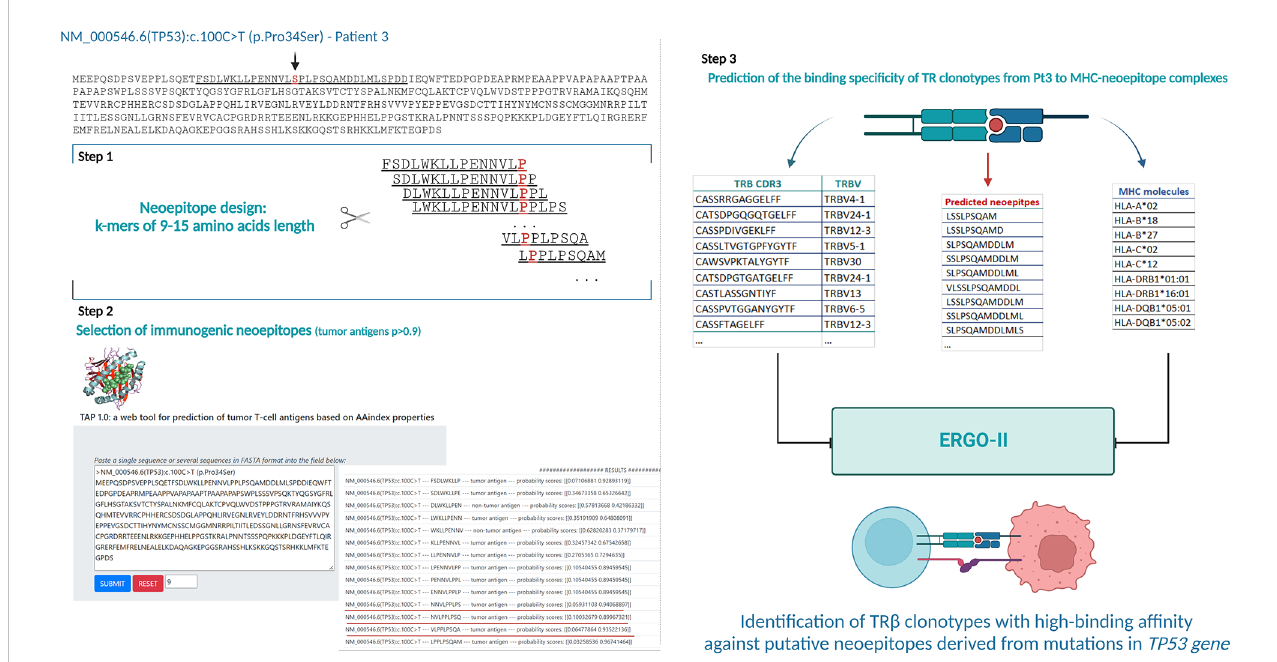
FIGURE 6 Analytical work fl ow for the prediction of neoepitopes and search for neoepitope-speci fi c clonotypes (Illustrative case of Pt3). Identi fi cation of putative tumor-derived epitopes on TAP 1.0 tool using the mutant protein sequence of each case (Step 1 and 2). Lists of the TR clonotypes, in silico predicted neoepitopes and MHC molecules from each patient used for prediction of their binding af fi nity in ERGO-II (Step 3). Created with